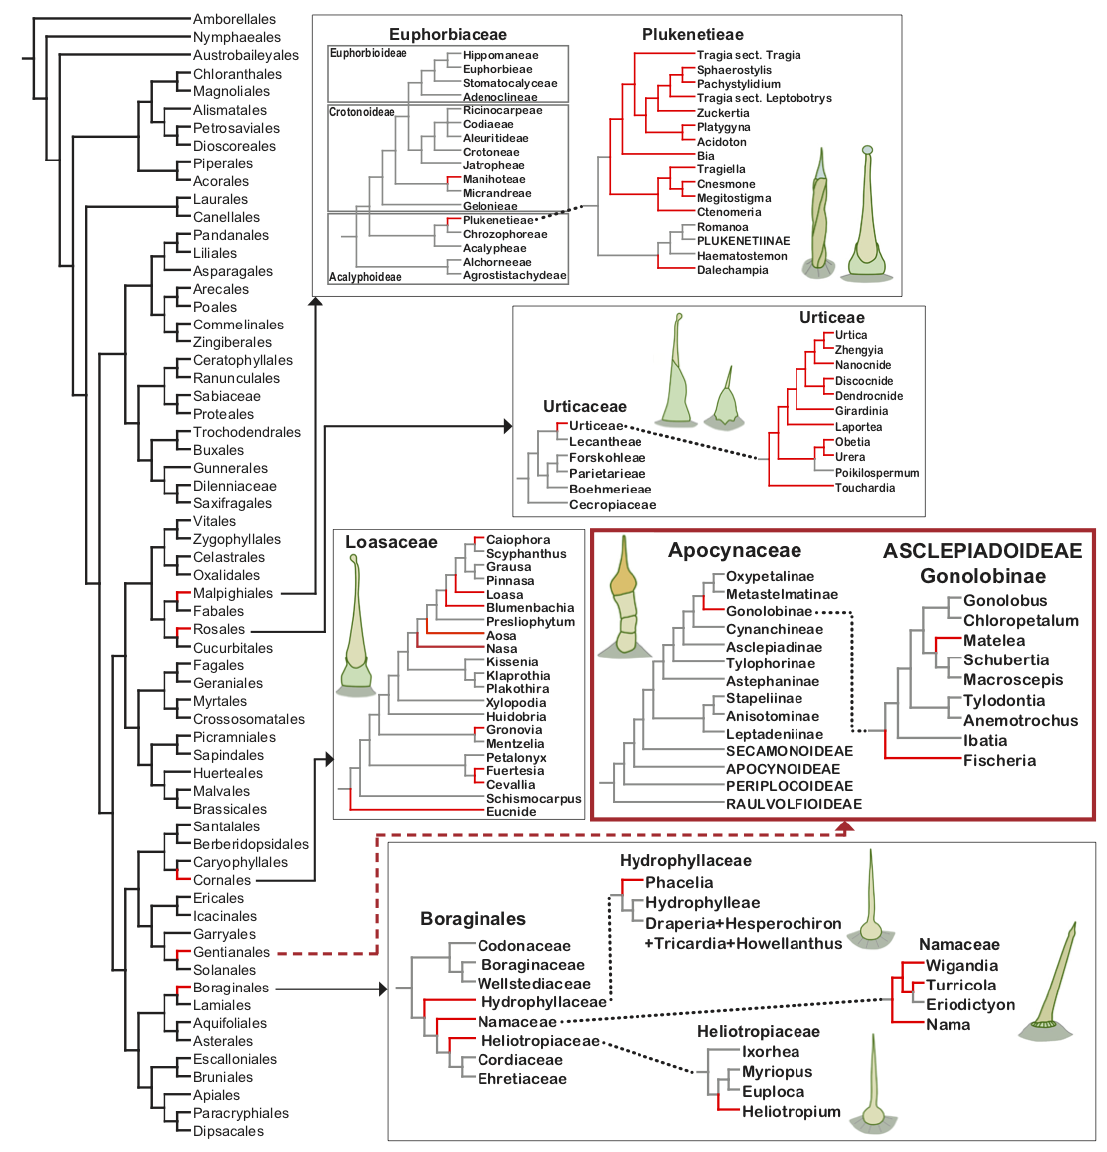
Figure 4. Simplified phylogenetic trees of the seven families that possess stinging trichomes, as well as of the more recently circumscribed order Boraginales showing the position of Hydrophyllaceae, Heliotropiaceae and Namaceae. Taxa where stinging trichomes occur are pointed out in red. Schematic drawings illustrate the trichome type found in the different families. Phylogenetic trees based on Huang et al. [39] and Wu et al. [40] for Urticaceae, Wurdack et al. [41] and Cardinal-McTeague and Gillespie [42] for Euphorbiaceae, Castillo et al. [43] and Hufford et al. [44] for Loasaceae, Mangelsdorff et al. [45] and Nazar et al. [46] for Apocynaceae, Hasenstab–Lehman [47] for Boraginales, Vasile et al. [48] for Hydrophyllaceae and Namaceae, and Hilger and Diane [49] for Heliotropiaceae.